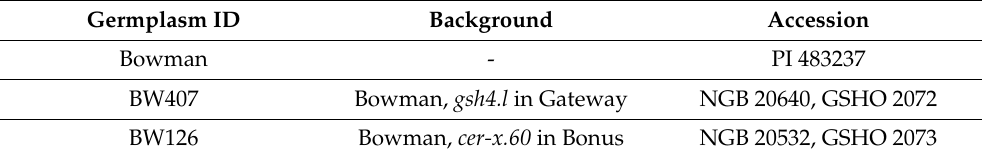
Table 1. Major germplasm used within this study. Germplasm ID